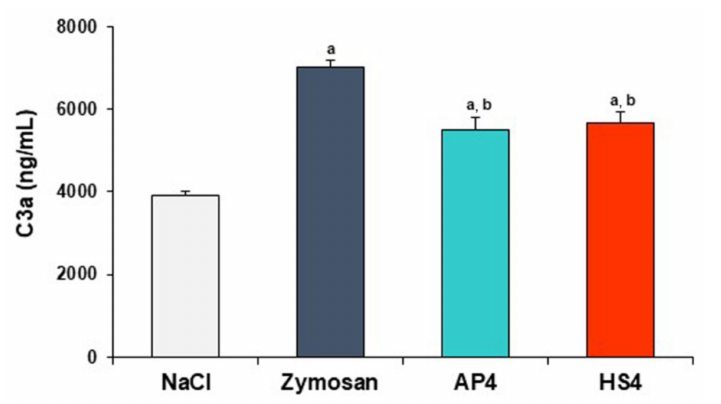
Figure 15. Effect of AP4 and HS4 gel beads on the C3a production in the whole blood in vitro. Results are presented as the mean ± S.D. (n = 8). a and b — p < 0.05 vs. NaCl and Zymosan,